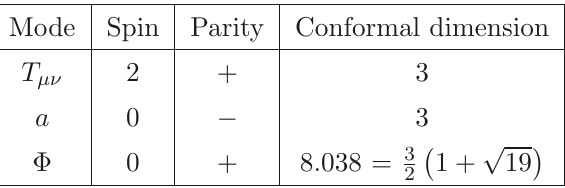
(cid:1) Table 1 . The low-lying single-trace operator dimensions for CFT duals of the Large Volume